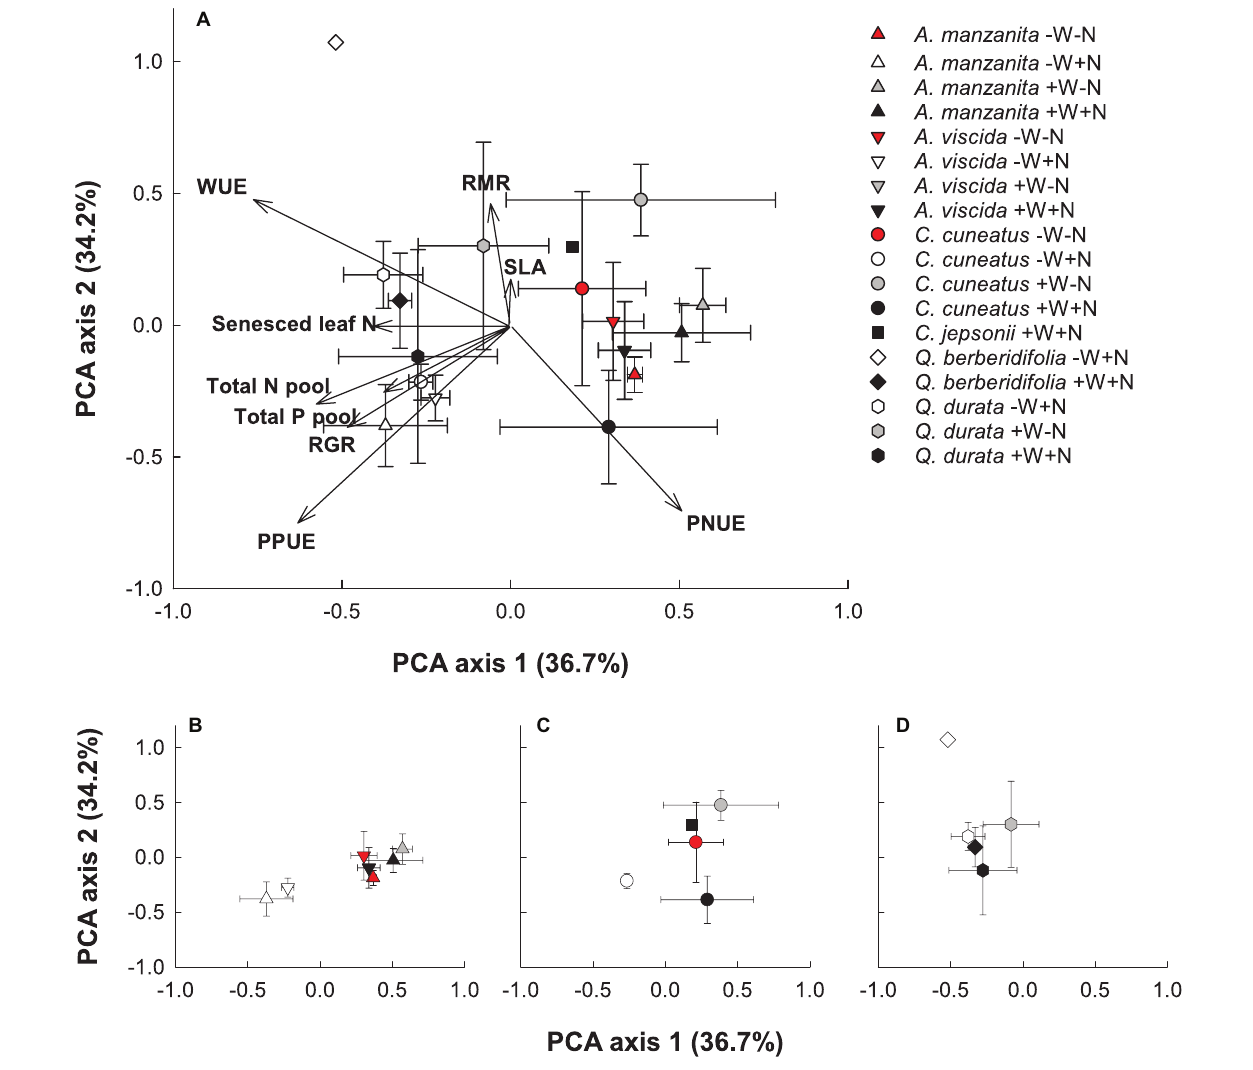
FIGURE 7 | Principal components analysis (PCA) visualization of functional trait responses of focal taxa (A) . Centroids are species means ± S.D. ( n = 1–4). Congener responses presented separately in smaller panels: Arctostaphylos (B) , Ceanothus (C) , and Quercus (D) . A. manzanita (up triangle), A. viscida (down triangle), C. cuneatus (circle), C. jepsonii (square), Q. berberidifolia (diamond), and Q. durata (hexagon). Low water, low nutrients (red); low water, high nutrients (white); high water, low nutrients (gray); high water, high nutrients (black). Due to missing trait values for some replicates, not all species by treatment combinations were retained in the